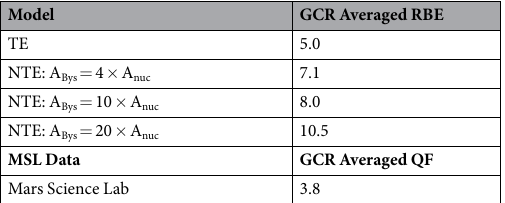
Model GCR Averaged RBE